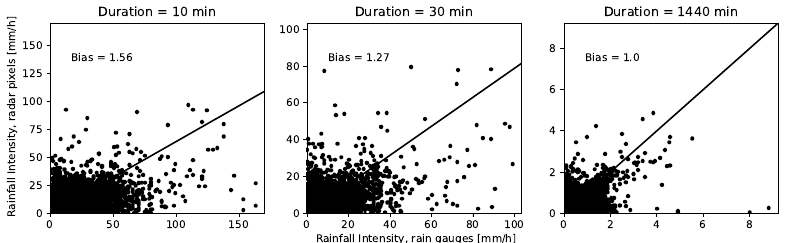
Figure 6. Biases for duration of 10, 30, and 1440 min. Biases are calculated by Equation (4).